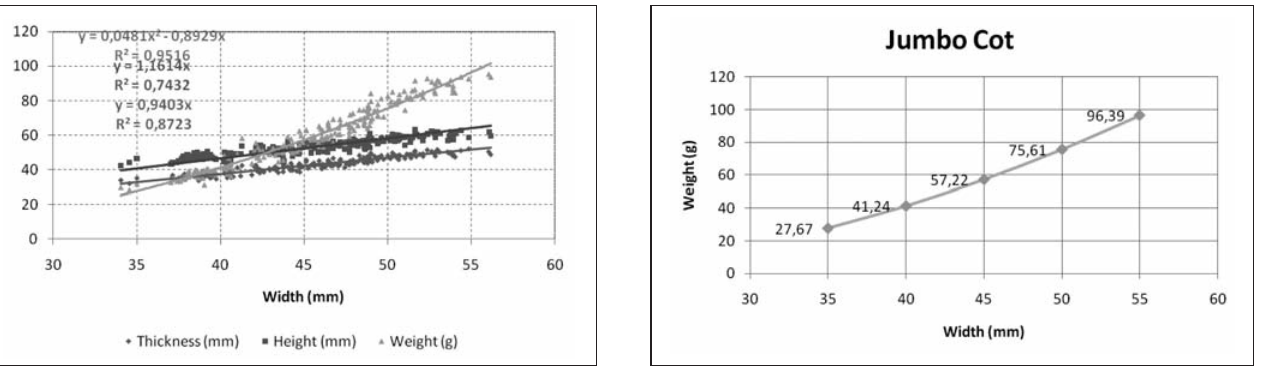
Fig. 19 Weight values calculated from the width-weight formula